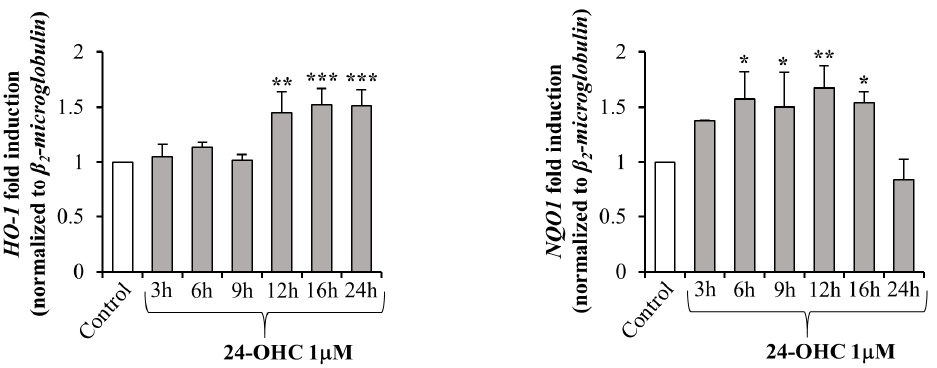
RT-PCR in cells treated with 1 µ M 24-OHC up to 24 h. Data, normalized to the corresponding ± SD of 3 different experiments. * p < 0.05, β Figure 4. Nrf2-target gene expression. HO-1 and NQO1 expression was quantified by real-time RT- 2 -microglobulin, are expressed as mean values PCR in cells treated with 1 μ M 24-OHC up to 24 h. Data, normalized to the corresponding β 2 -micro- ** p < 0.01, *** p < 0.001 vs. globulin, are expressed as mean values ± SD of 3 different experiments. * p < 0.05, ** p < 0.01, *** p < 0.001 vs. control.